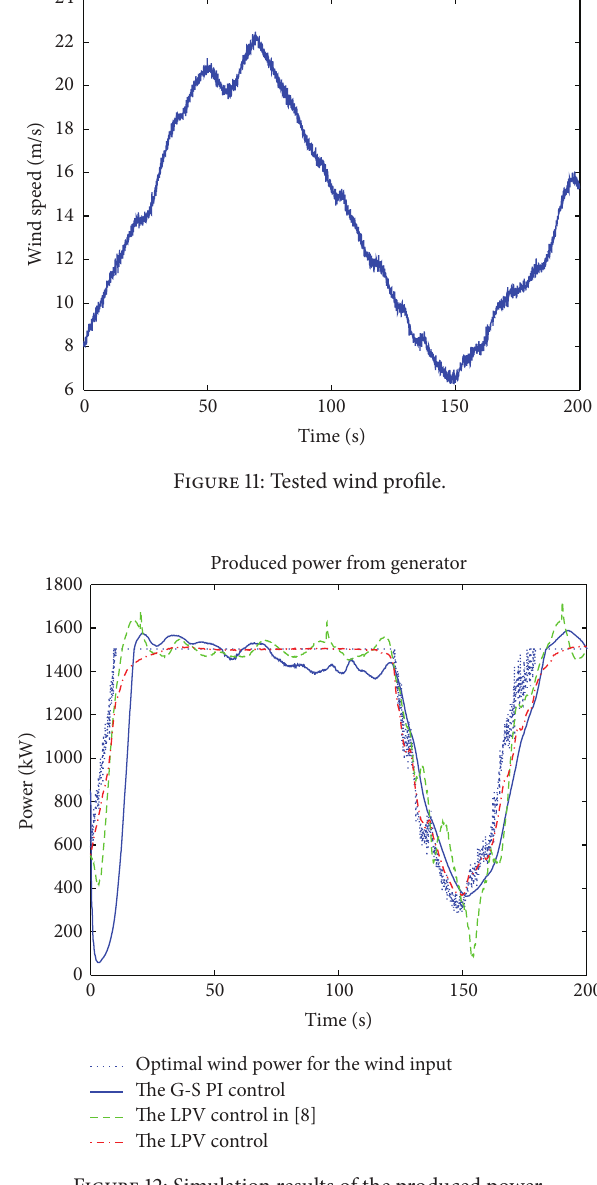
Figure 12: Simulation results of the produced